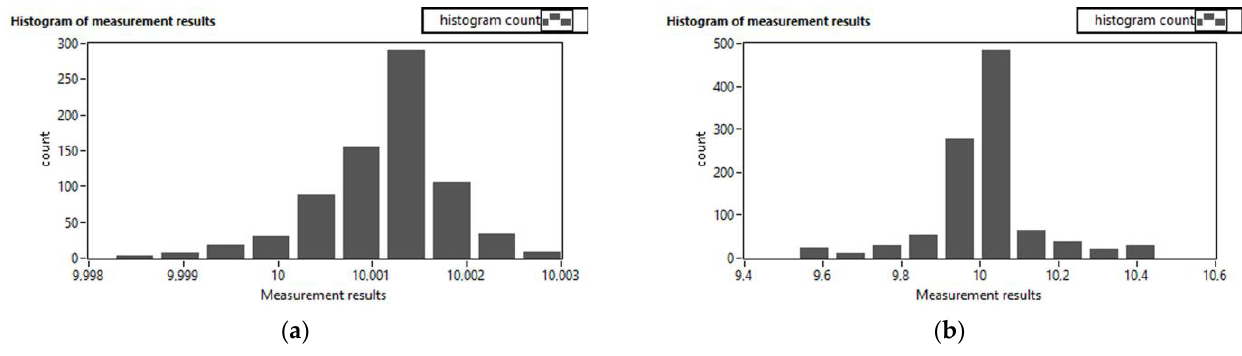
Figure 19. Histograms of individual results from a series of n = 1024 measurements made for the tested module NI USB-9215: ( a ) at low interference level, ( b ) at high interference level.